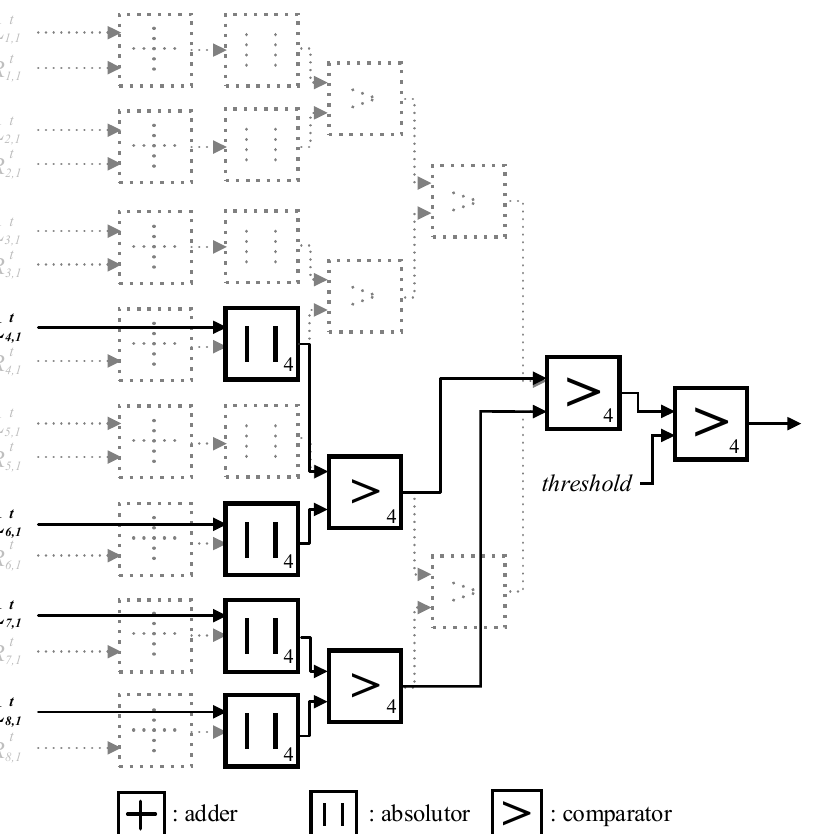
Figure 6. Proposed early-termination structure for (8, 4) polar codes.